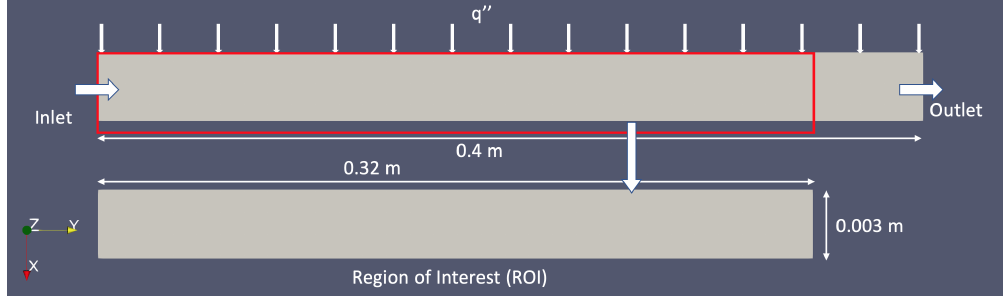
Figure 1. CFD simulation domain and selected region of interest for data